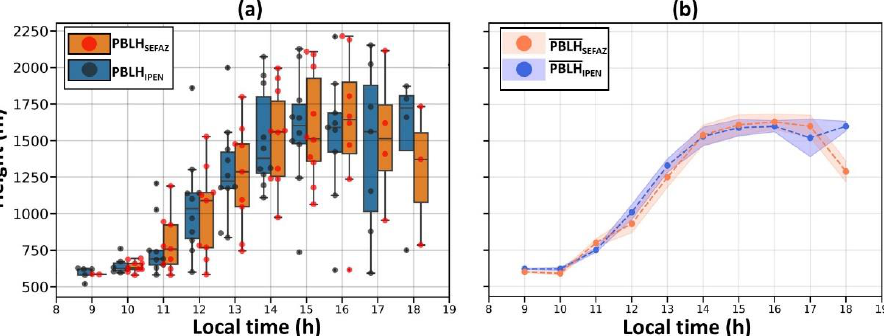
Figure 7. Diurnal evolution of ( a ) hourly values of PBLH IPEN (black dots) and PBLH SEFAZ (orange dots) and ( b ) average values of PBLH IPEN ( PBLH̅̅̅̅̅̅̅ IPEN , blue dots) and PBLH SEFAZ ( PBLH̅̅̅̅̅̅̅ SEFAZ , orange dots). PBLH values were retrieved from the WCT method during the 12-day field campaign of 2019. Symbols in ( a ) obey the boxplot standard. In ( b ), the statistical error is indicated by blue and red shadow bands.